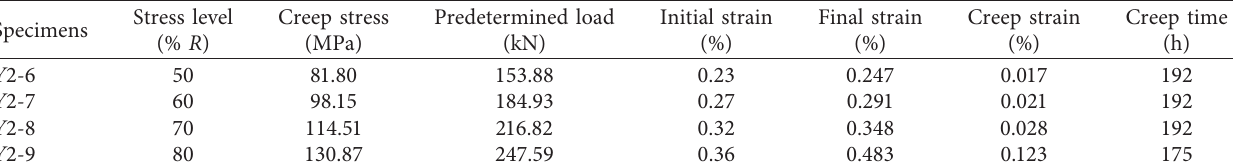
Table 2: Uniaxial creep statistics of the iron ore specimens.